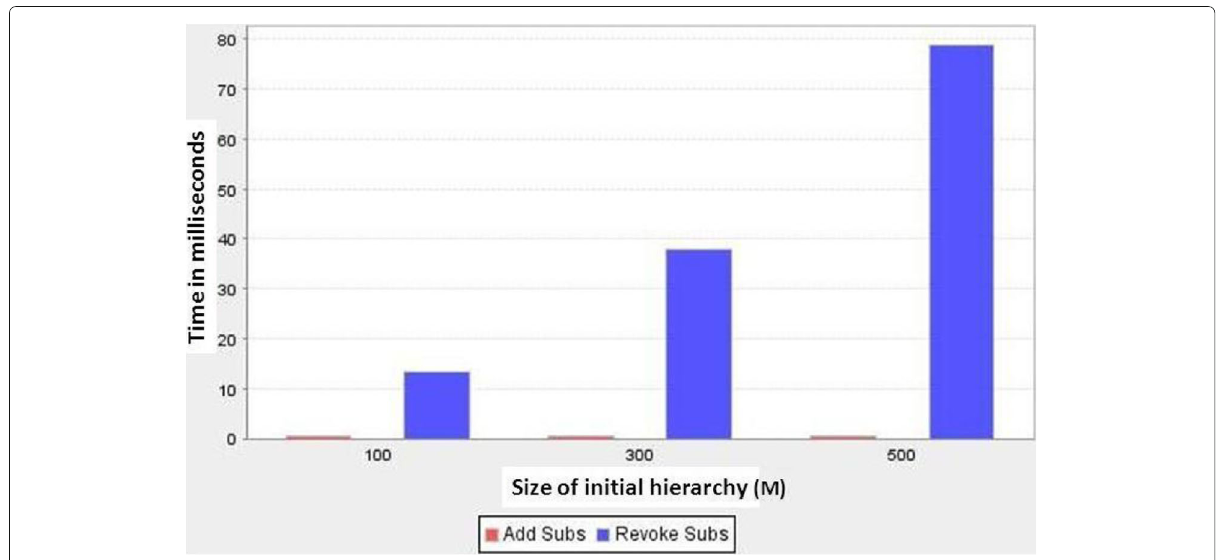
Fig. 13 Permission operation cost